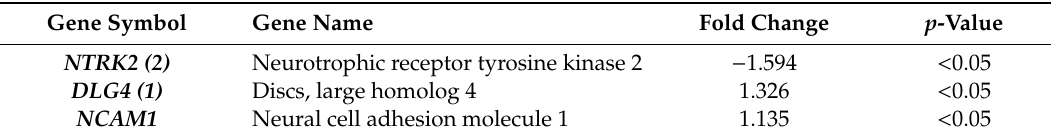
Table 3. Relative mRNA expression levels of selected genes for TERM-CON. Values are scaled to PRE-CON set to 1. Numbers in brackets indicate primer number if several primers for the same gene were tested.